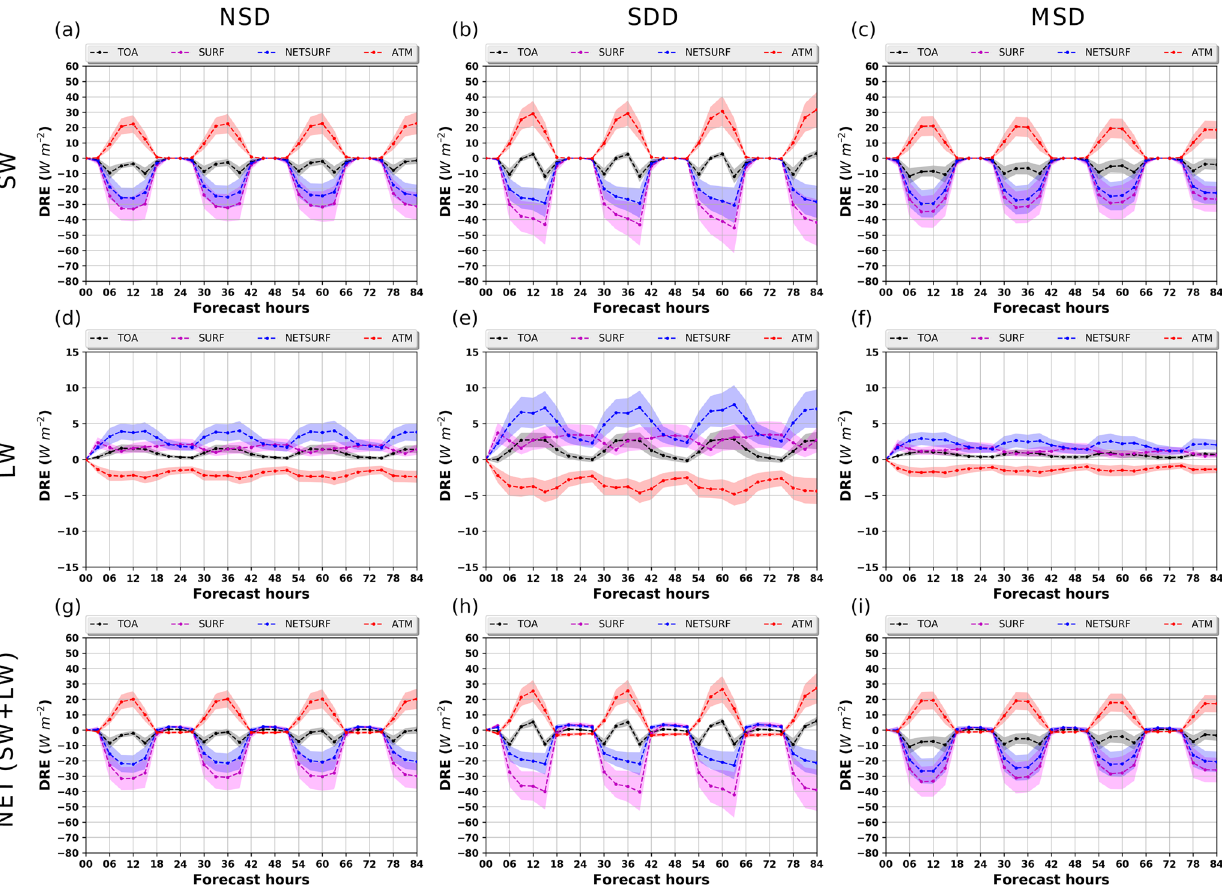
Figure 5. Regional all-sky SW ( a–c ), LW ( d–f ) and NET (SW + LW) ( g–i ) DREs at TOA (black), SURF (purple), NETSURF (blue) and ATM (red) averaged over the NSD ( a, d, g ), SDD ( b, e, h ) and MSD ( c, f, i ) domains. The calculated DREs correspond to the mean values calculated from the 20 simulated Mediterranean desert dust outbreaks, and the shaded areas represent the associated standard